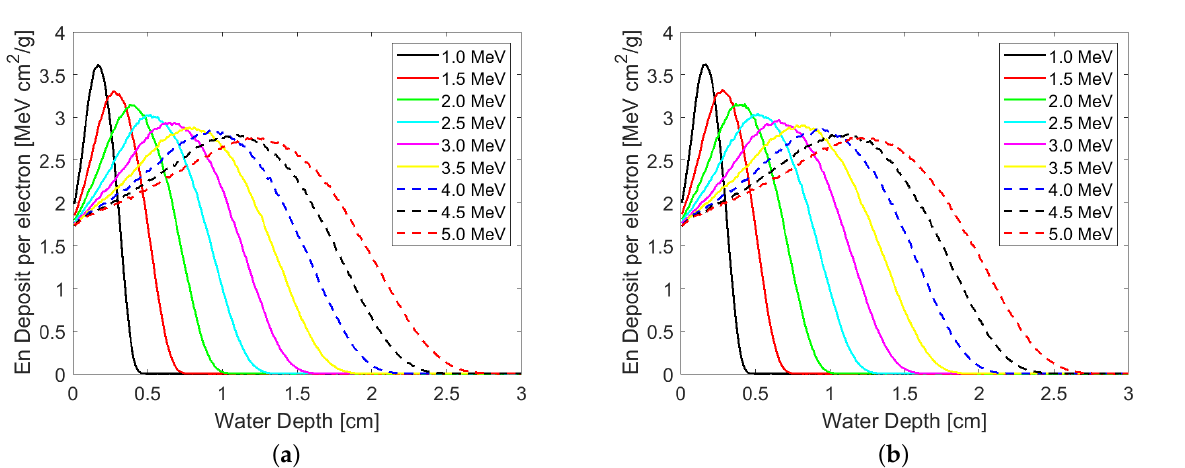
Figure 6. Depth-dose curves generated by different energies of electrons in water in the simulation by using the ( a ) Livermore and ( b ) Penelope set of